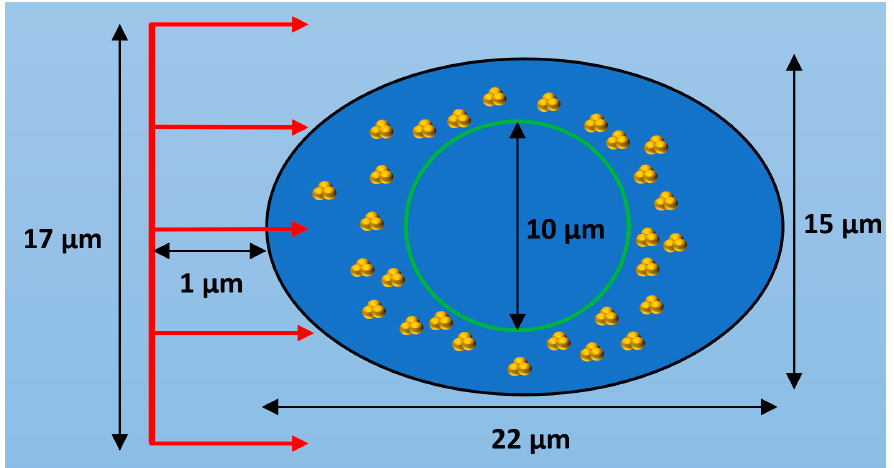
Figure 8. Diagram of cell model showing a cross section of the ellipsoid cell with a black outline with the spherical nucleus shown by a green outline and GNP clusters distributed within the cytoplasm. The incident proton beam is shown in red and is travelling in the positive Z direction. Not to scale.